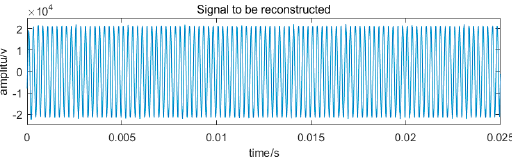
Figure 10. The original signal.